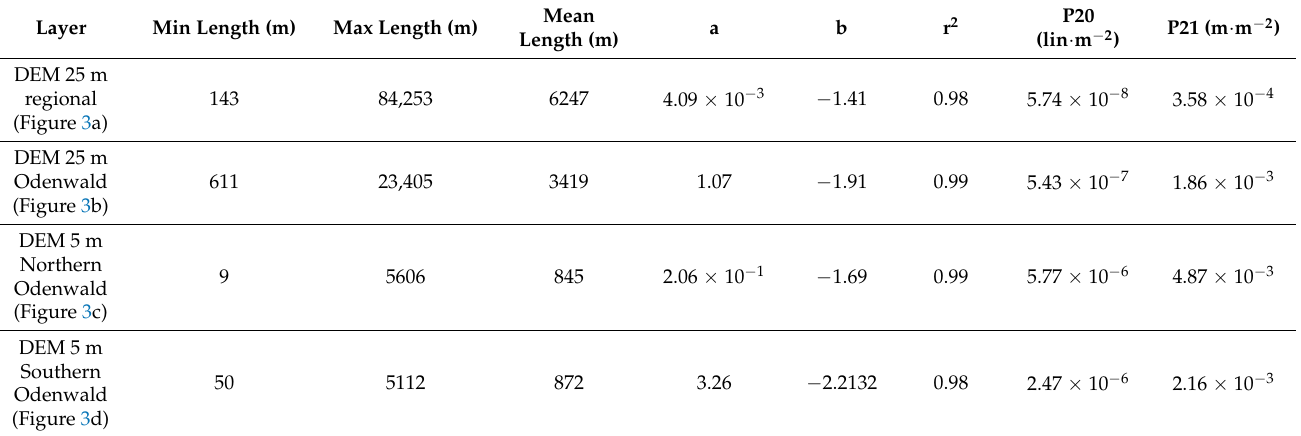
Table 2. Lineament analysis statistics, with dimension features, power-law parameters a, b, and r 2 , and areal fracture density and